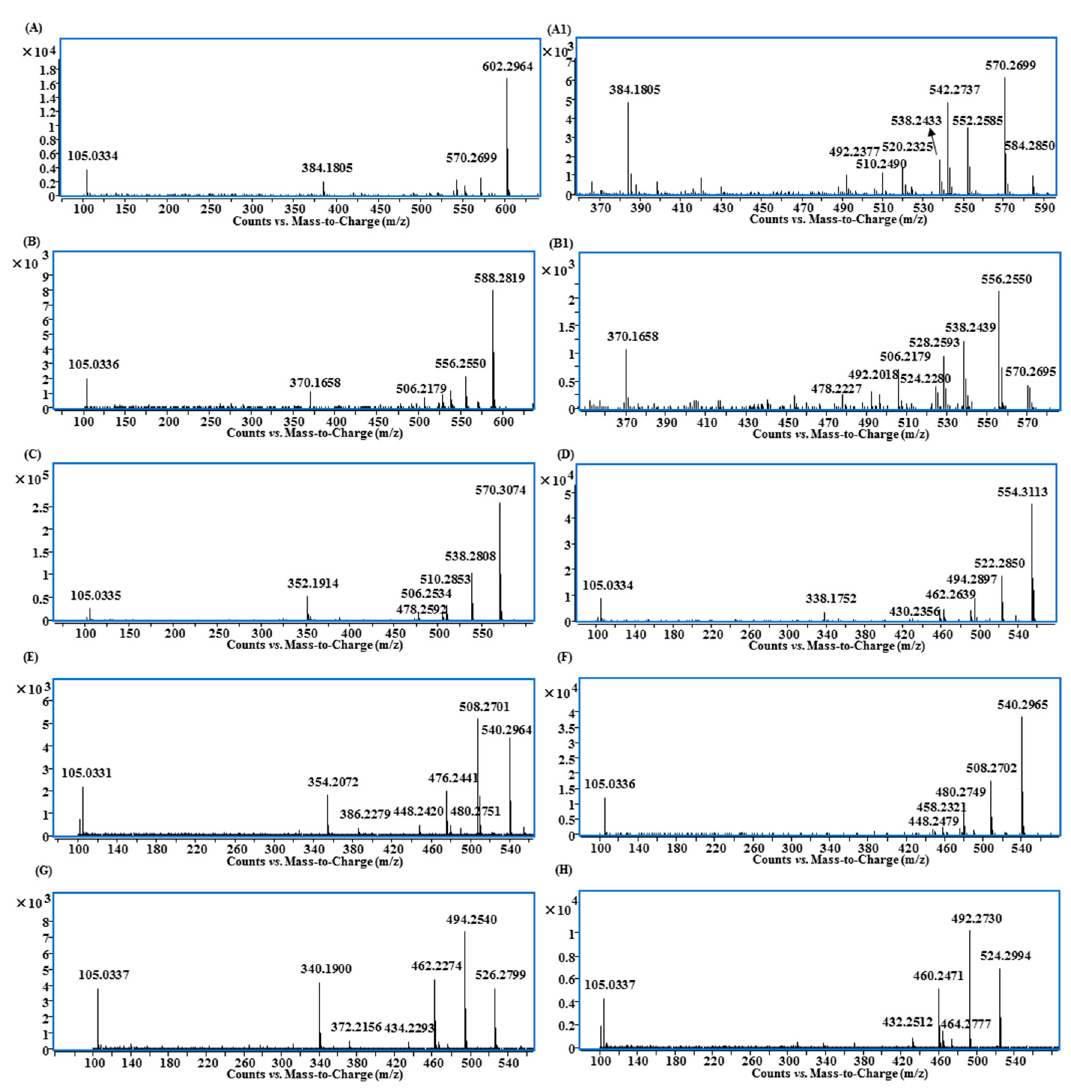
Figure 6. MS/MS spectra of lipo-alkaloids with the basic skeletons of: ( A and A1 ) 10-OH-BA; ( B and B1 ) 10-OH-BMA; ( C ) 3-DBA; ( D ) 3,13-DDBA; ( E ) 3-DMDBA; ( F ) 13-DMDBA; ( G ) DMBHA; ( H ) DMDDBA.